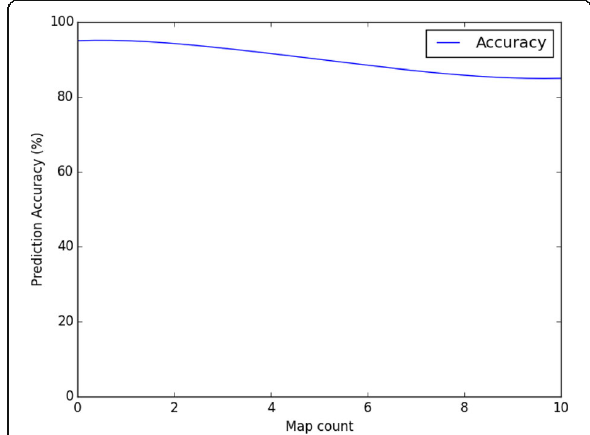
Fig. 7 Graph of classifier accuracy against the number of maps